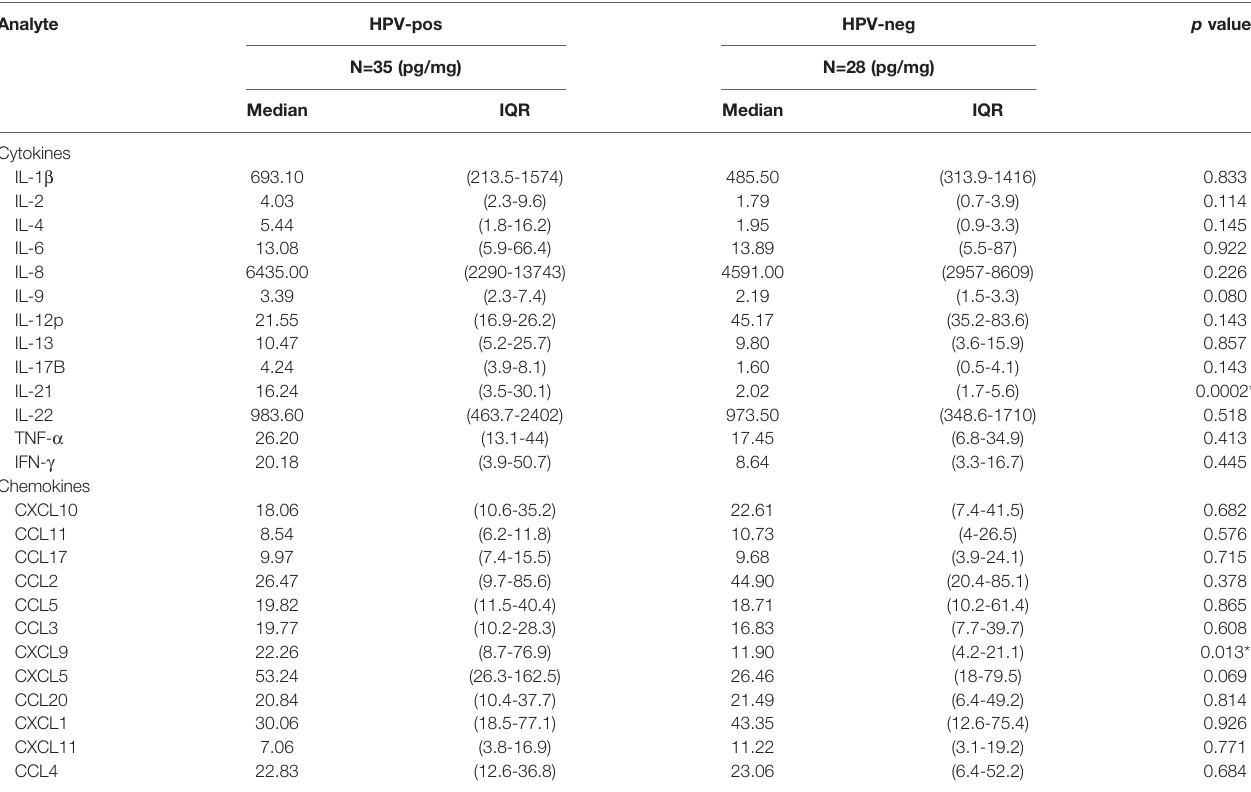
TABLE 3 | Cytokine and chemokine concentrations in cervicovaginal mucus from women with symptomatic cervical ectopy.